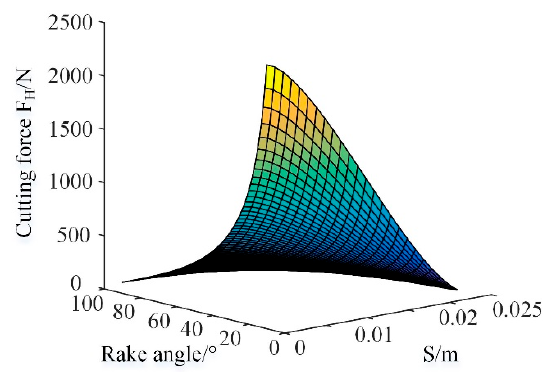
Figure 13. 3D surface of the cutting force F H with the blade displacement from 0 to 0.024 m and the rake angle from 10° to 90°.